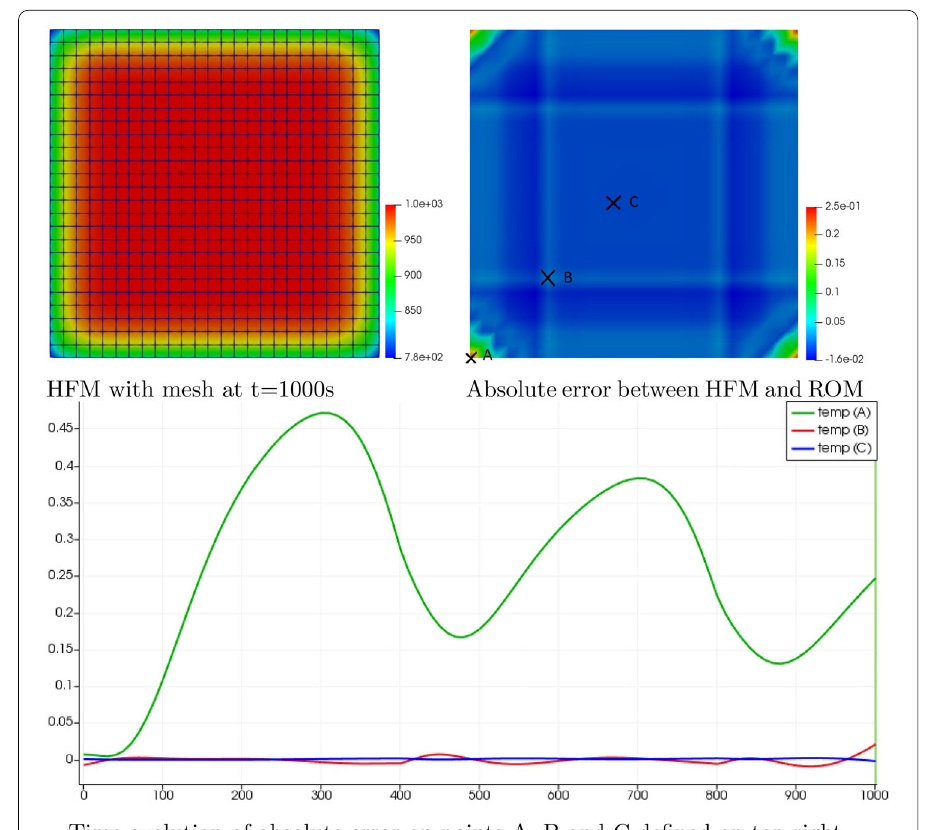
Fig. 5 Simple test case with radiation only using Z-set